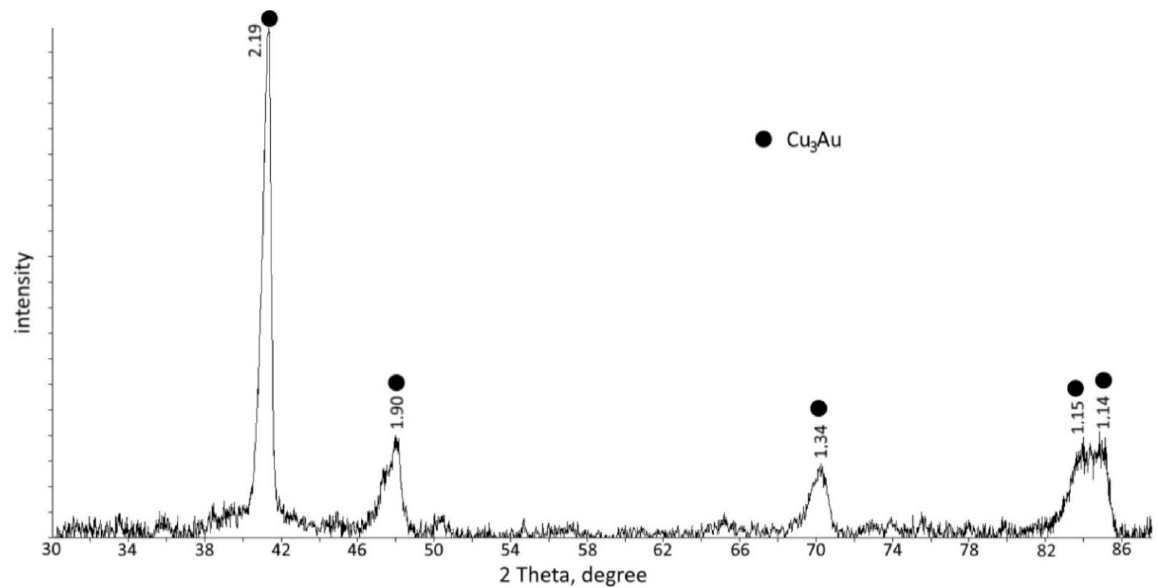
Figure 17. X-ray diffraction pattern of quenched (cold water) Cu-Ag-Au spherules obtained in experimental melting runs at atmospheric conditions (see text for